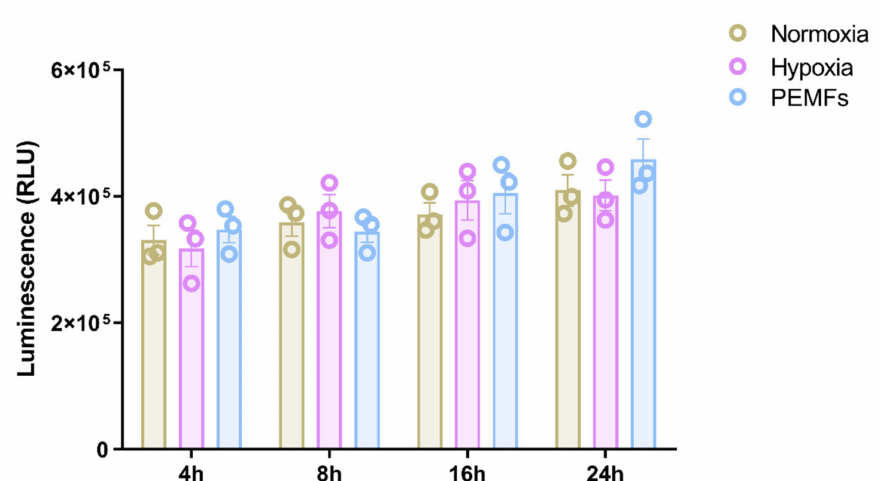
Figure 1. 1321N1 cell viability in conditions of normoxia, hypoxia or PEMF exposure in normoxia. 1321N1 cells were incubated from 4 to 24 h in normoxia in the absence or presence of PEMFs and hypoxic conditions. Cell viability was assessed by measuring intracellular ATP content. Luminescence values expressed as relative light unit (RLU) and proportional to intracellular ATP content are reported as an index of SH-SY5Y cell viability. Data are expressed as the mean ± SEM of three independent experiments.